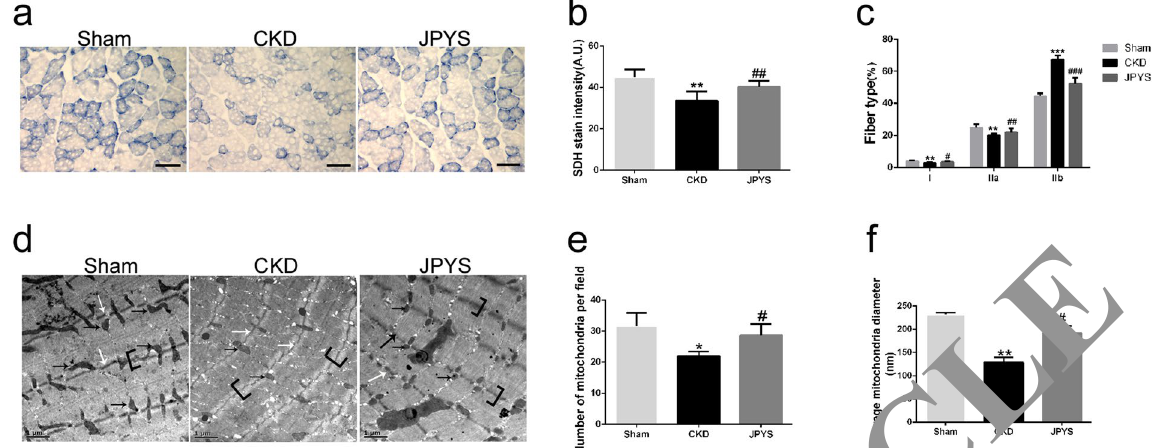
Figure 4. Effect of JPYS decoction on skeletal muscle mitochondrial content and fiber type in 5/6 nephrectomised rats. ( a ) SDH staining was performed on 10 μ m-thick sections from gastrocnemius muscles frozen in liquid nitrogen-cooled isopentane. ( b ) Quantification of SDH-stain intensity (expressed in A.U) and ( c ) number of type I (slow oxidative), and IIa (fast oxidative glycolytic) muscle fibers and type IIb (fast glycolytic) muscle fibers was assessed. Scale bar: 100 μ m. Electron microscopy micrographs (magnification: 12,000x) of Gastroc muscles ( d ). Black arrows indicate mitochondria. Scale bar: 1 µ m. Quantification of mitochondrial amount (number per field) ( e ) and size (average diameter, nm) ( f ) were performed. Results are presented as mean ± SD, n = 6 per group, * P < 0.05, ** P < 0.01, *** P < 0.001 between Sham and CKD groups. # P < 0.05, ## P < 0.01, ### P < 0.001 between CKD and JPYS groups.